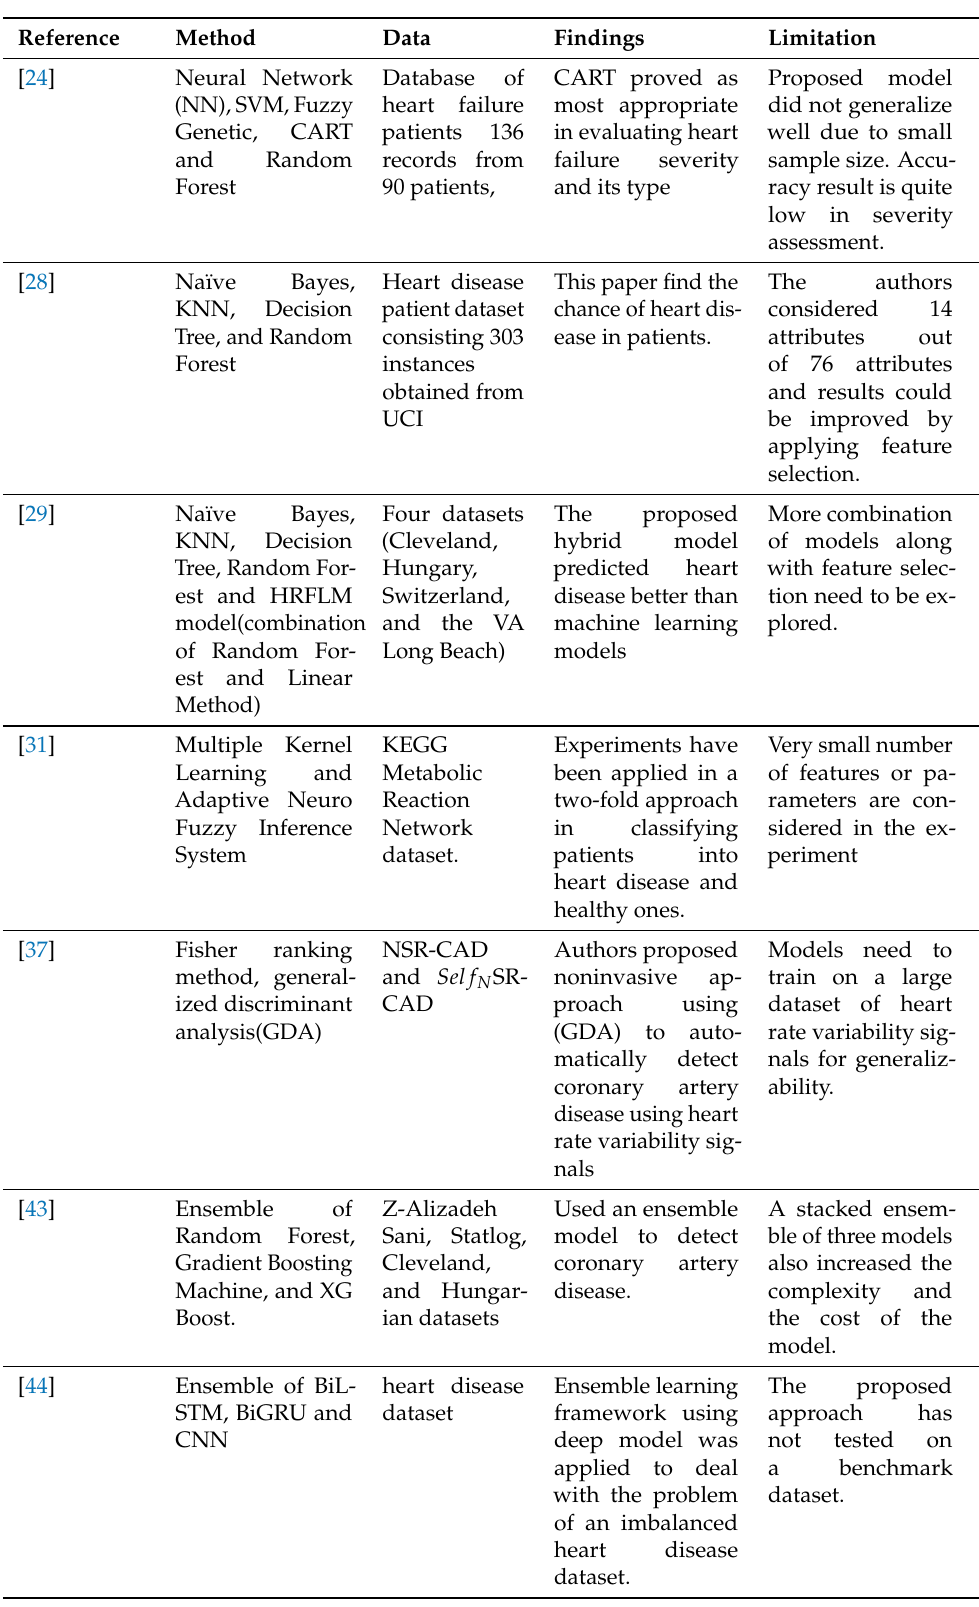
Table 1. Overview the existing studies from the